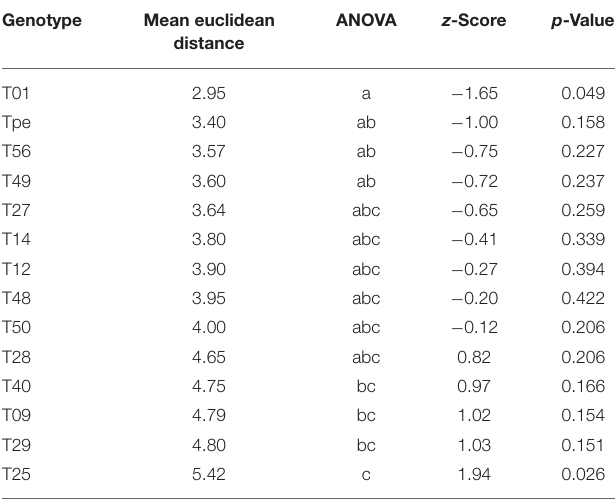
TABLE 2 | Evaluation of distance between the genotypes and the respective treatment. Genotype